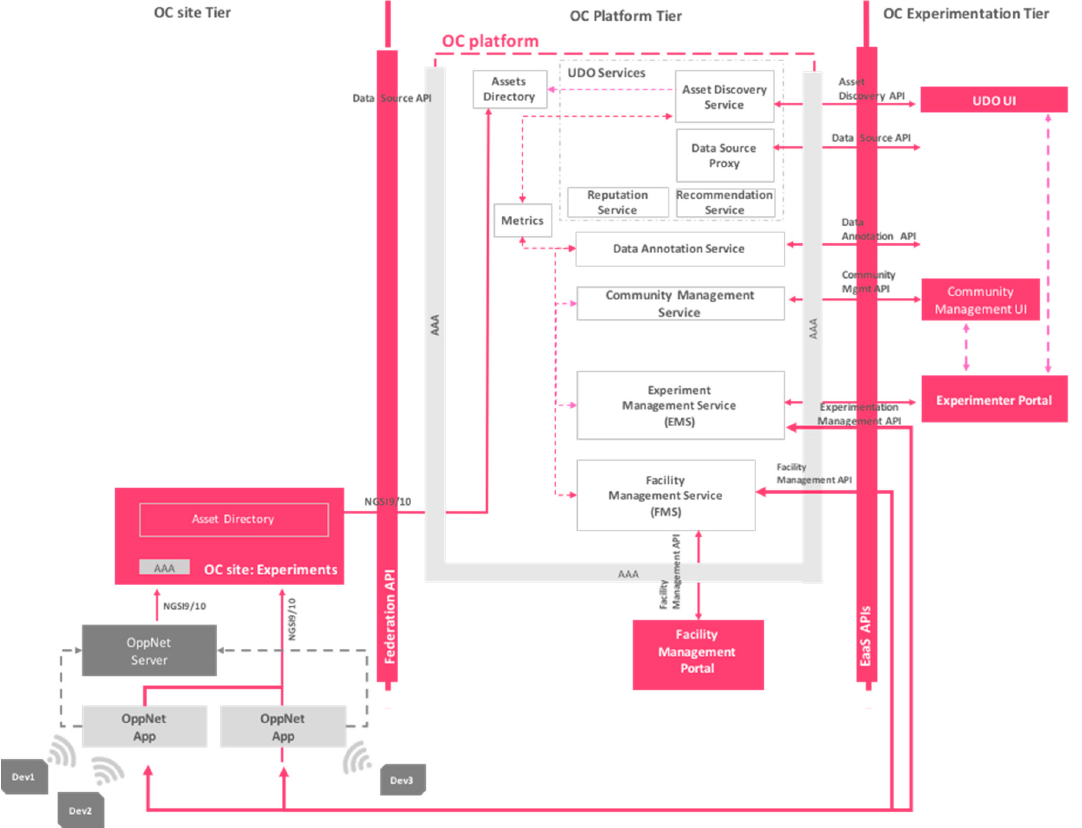
Figure 9. Overview of Opportunistic Communication integration with OC platform.